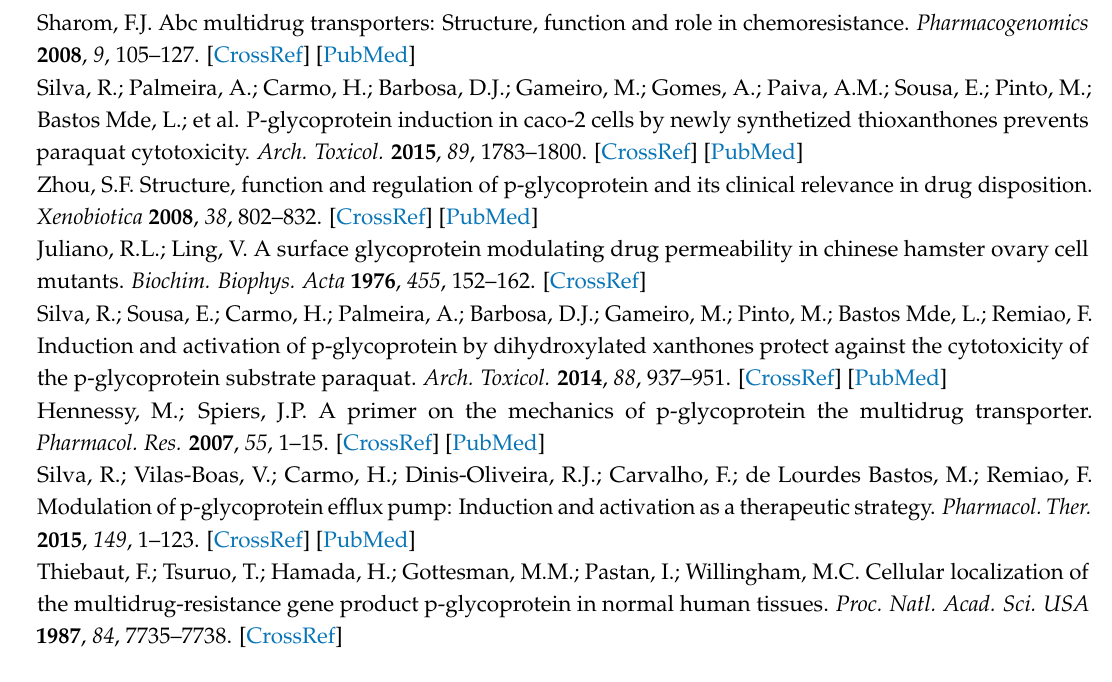
Supplementary Materials: The following are available online, Figure S1. Representative histograms of flow cytometry analysis of Caco-2 cells autofluorescence in the 530 ± 15 nm band-pass filter (A - FL1 detector) and in the 585 ± 40 nm band-pass filter (B - FL2 detector), 24 h after the incubation with the tested oxygenated xanthones OX1-6 (20.0 µ M). Figure S2. Representative histograms of flow cytometry analysis of P-gp expression, evaluated 24 h after exposure of Caco-2 cells to the oxygenated xanthone OX4 (20.0 µ M), using the UIC2-PE monoclonal antibody (585 ± 40 nm band-pass filter - FL2 detector). Figure S3. Representative histograms of flow cytometry analysis of P-gp activity, evaluated 1 h after exposure of Caco-2 cells to the oxygenated xanthone OX6 (20.0 µ M), using Rhodamine (Rho 123) as a fluorescent substrate (530 ± 15 nm band-pass filter - FL1 detector). Figure S4. Representative histograms of flow cytometry analysis of P-gp activity, evaluated 24 h after exposure of Caco-2 cells to the oxygenated xanthone OX5 (20.0 µ M), using Rhodamine (Rho 123) as a fluorescent substrate (530 ± 15 nm band-pass filter - FL1 detector). Figure S5 . Elacridar (Ela, 0 - 10.0 µ M) cytotoxicity in Caco-2 cells evaluated by the Neutral Red (NR) uptake assay, 24 h after incubation. Figure S6. Paraquat (PQ) concentration-response (cell death) curve obtained in the absence (PQ) or in the presence of 10.0 µ M Elacridar (PQ + Ela). Table S1. EC50 (half-maximum-effect concentrations), TOP (maximal effect), BOTTOM (baseline) and Hill Slope values of the paraquat (PQ) concentration-response curve, with (PQ + Ela) or without (PQ) simultaneous exposure to Elacridar (10.0 µ